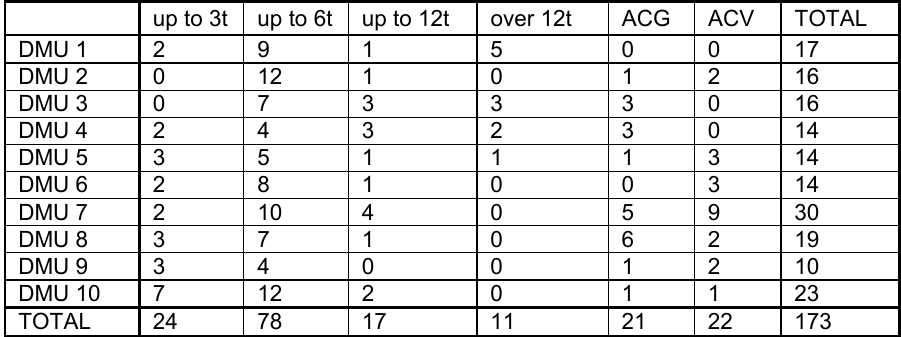
Table 2 – Overview of the number of vehicles by classes and units Таблица 2 – Обзор количества транспортных средств по классам и единицам Ta бела 2 – Преглед броја возила по класама и јединицама